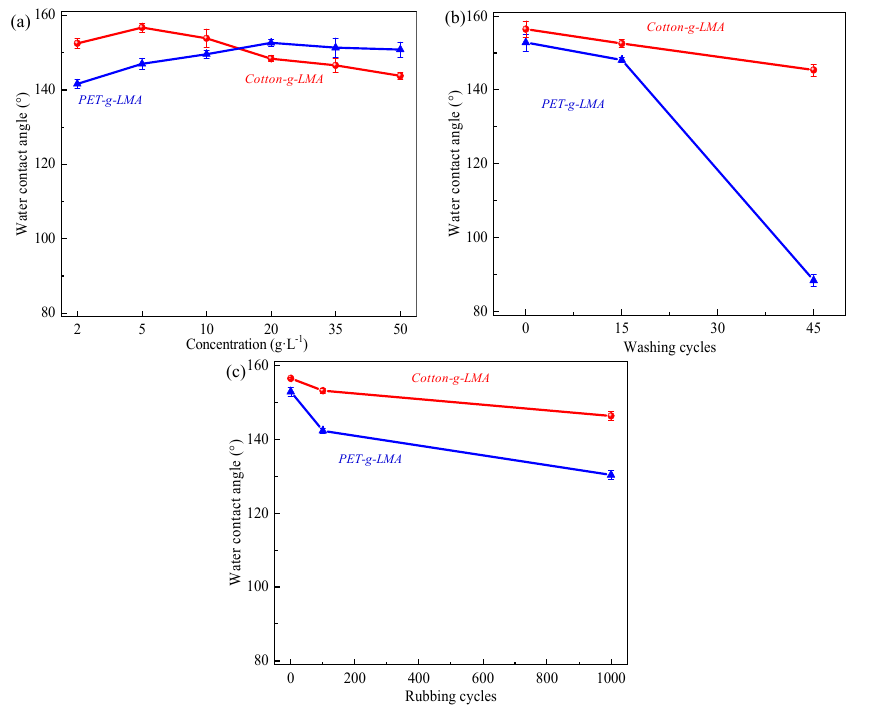
Figure 1. ( a ) Water repellency, ( b ) washing durability and ( c ) rubbing stability of Cotton- g -LMA and PET- g -LMA fabrics.